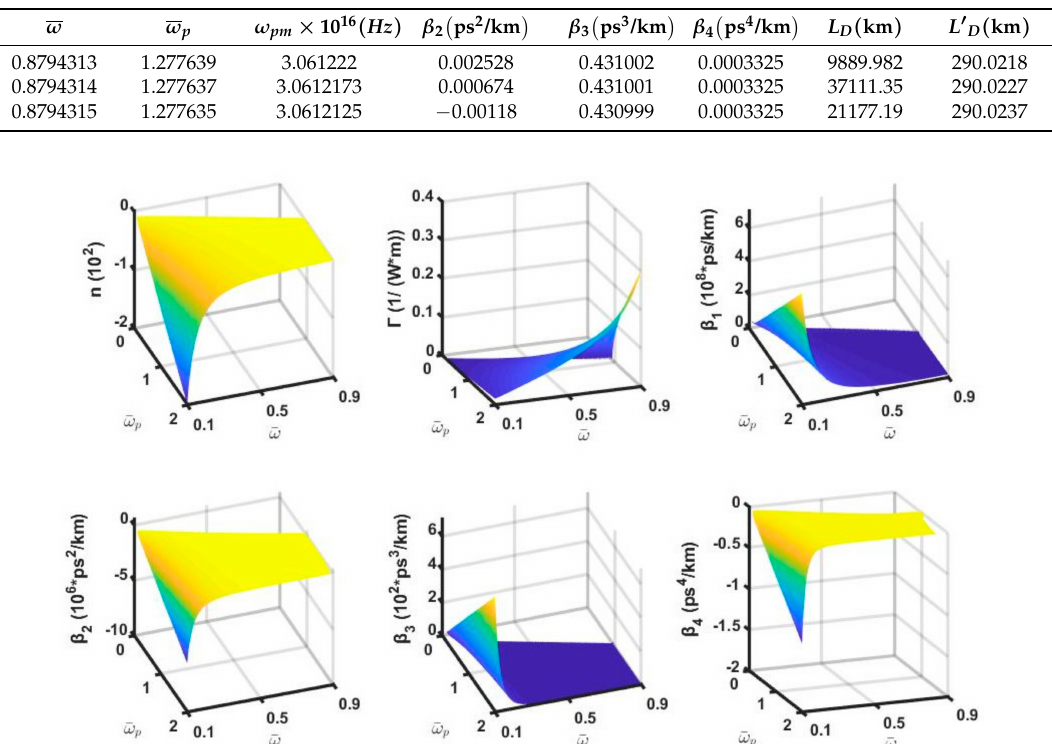
Figure 8. Dependence of refractive index, third-order nonlinear coefficient, first-, second-, third-, and forth-order dispersion on ω and ω p , with ω pe = 2.396 × 10 16 Hz.